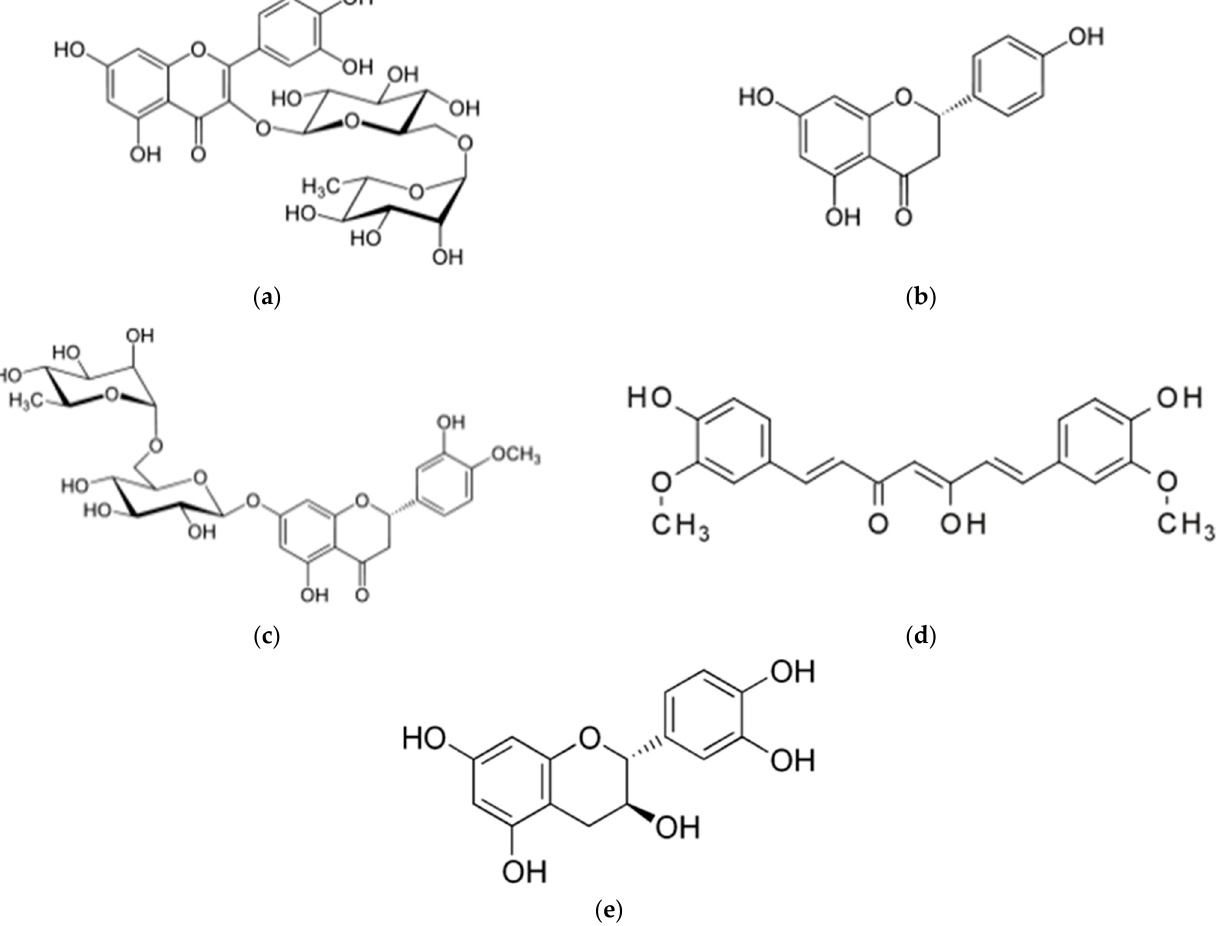
Figure 1. The chemical structure of the polyphenols studied in this experiment. ( a ) Rutin; ( b ) (S)- naringenin; ( c ) hesperidin; ( d ) curcumin; ( e ) (+)-catechin.